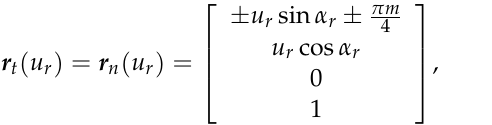
surfaces of the